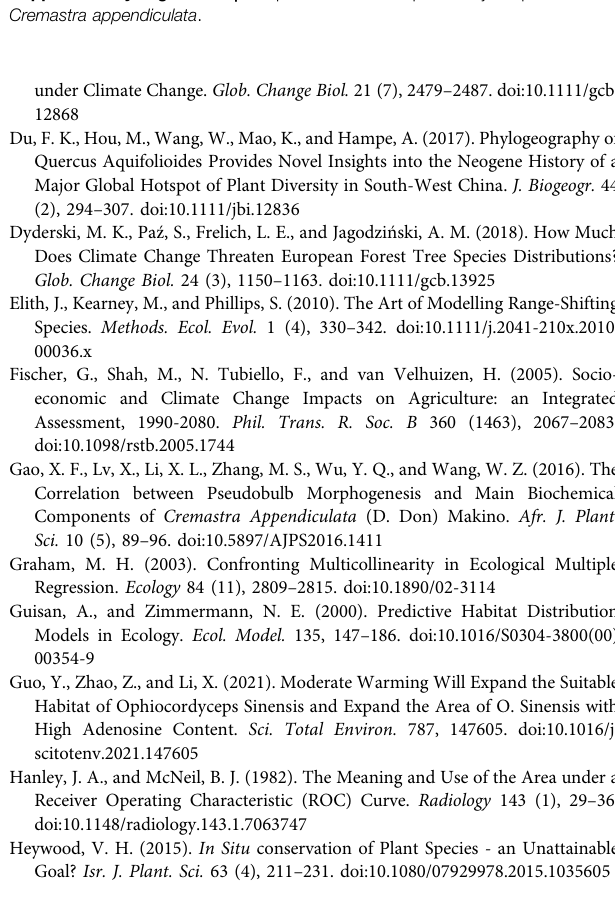
Supplementary Figure S1 | Reliability test of the distribution model created for Cremastra appendiculata . Supplementary Figure S2 | Suitable habitat area for Cremastra appendiculata under different scenarios of climate change. Supplementary Figure S3 | Changes in suitable habitat areas for Cremastra appendiculata in the future. Supplementary Figure S4 | Jackknife test of variable importance for Cremastra appendiculata. Supplementary Figure S5 | Response curves of probability of presence for Cremastra appendiculata